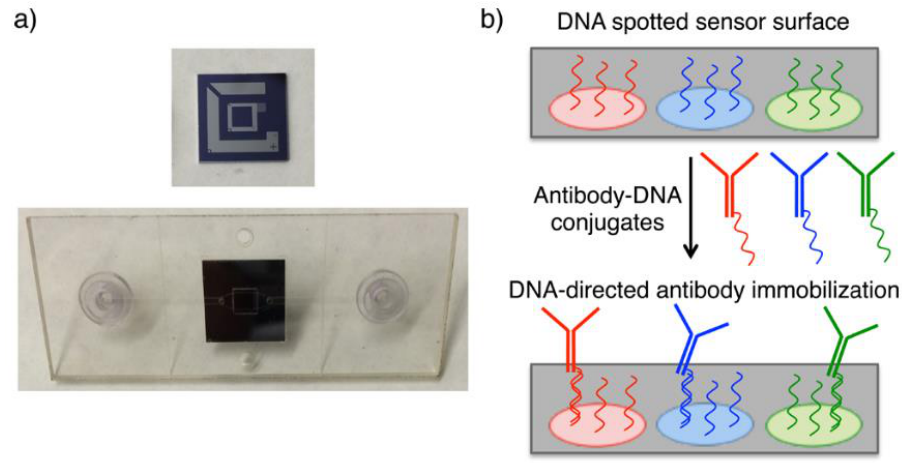
Figure 5. ( a ) Photos of IRIS chip and microfluidic cartridge. ( b ) Schematization of ssDNA spotted sensor area and antibody immobilization on the chip surface through DNA hybridization [44]. Re- produced with permission from E. Seymour, G.G. Daaboul, X. Zhang, S.M. Scherr, N.L. Ü nlü, J.H. Connor, M.S. Ü nlü, Analytical Chemistry; Published by American Chemical Society, 2015.